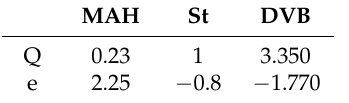
Table 2. Q – e values of MAH and comonomers.